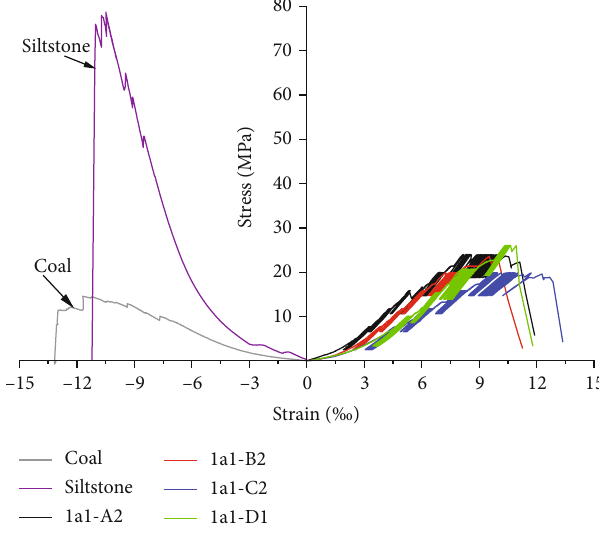
Figure 4: Strain-stress curves of siltstone, coal, and